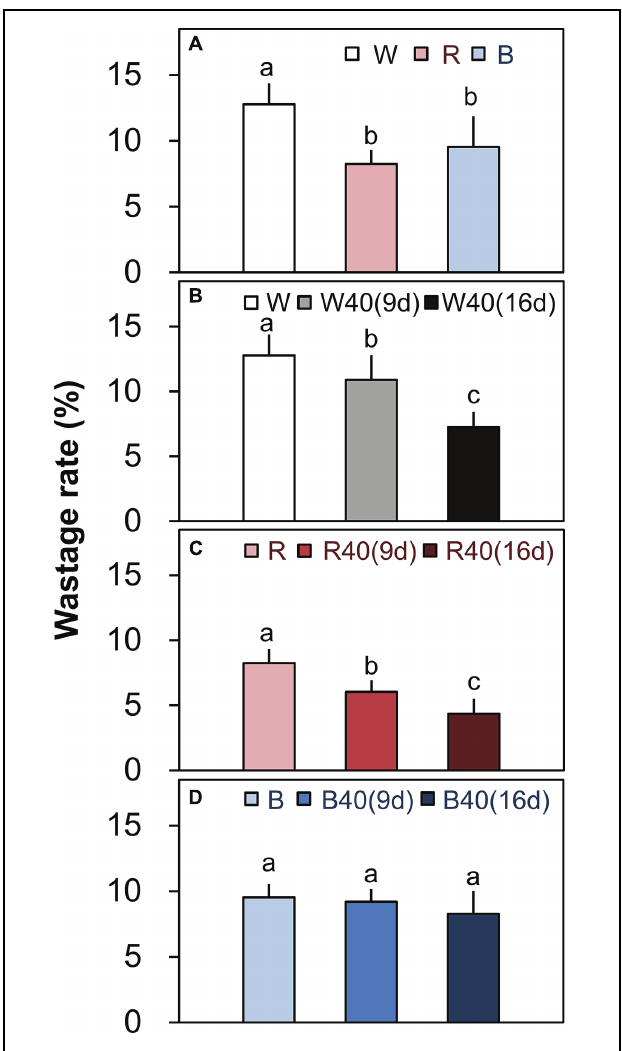
FIGURE 5 | Wastage rates (total leaf fresh weight minus marketable leaf fresh weight; Figure 4) of outer senesced leaves of plants grown under downward lighting by white, red, or blue LEDs (A) without and (B–D) with supplemental upward lighting. Data represent means ± SD ( n = 3 to 5). Supplemental upward lighting was provided for 9 days (“9d”) or 16 days (“16d”) at 40 µ mol m − 2 s − 1 PPFD. Bars labeled with different letters differ significantly between treatments (Tukey’s HSD test, P <